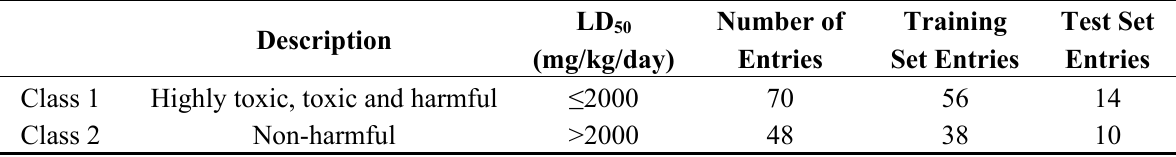
Table 8. Classifications of the 118 chemicals in the training and test sets prior to k -NN model